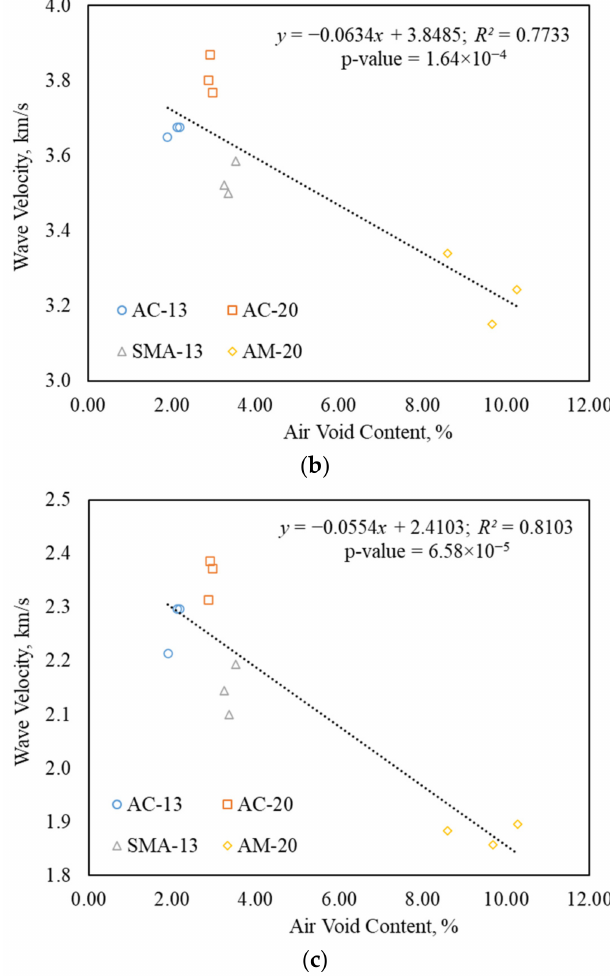
Figure 6. Wave velocity vs. air void content: ( a ) ultrasonic wave test; ( b ) P-wave test; ( c ) S-wave